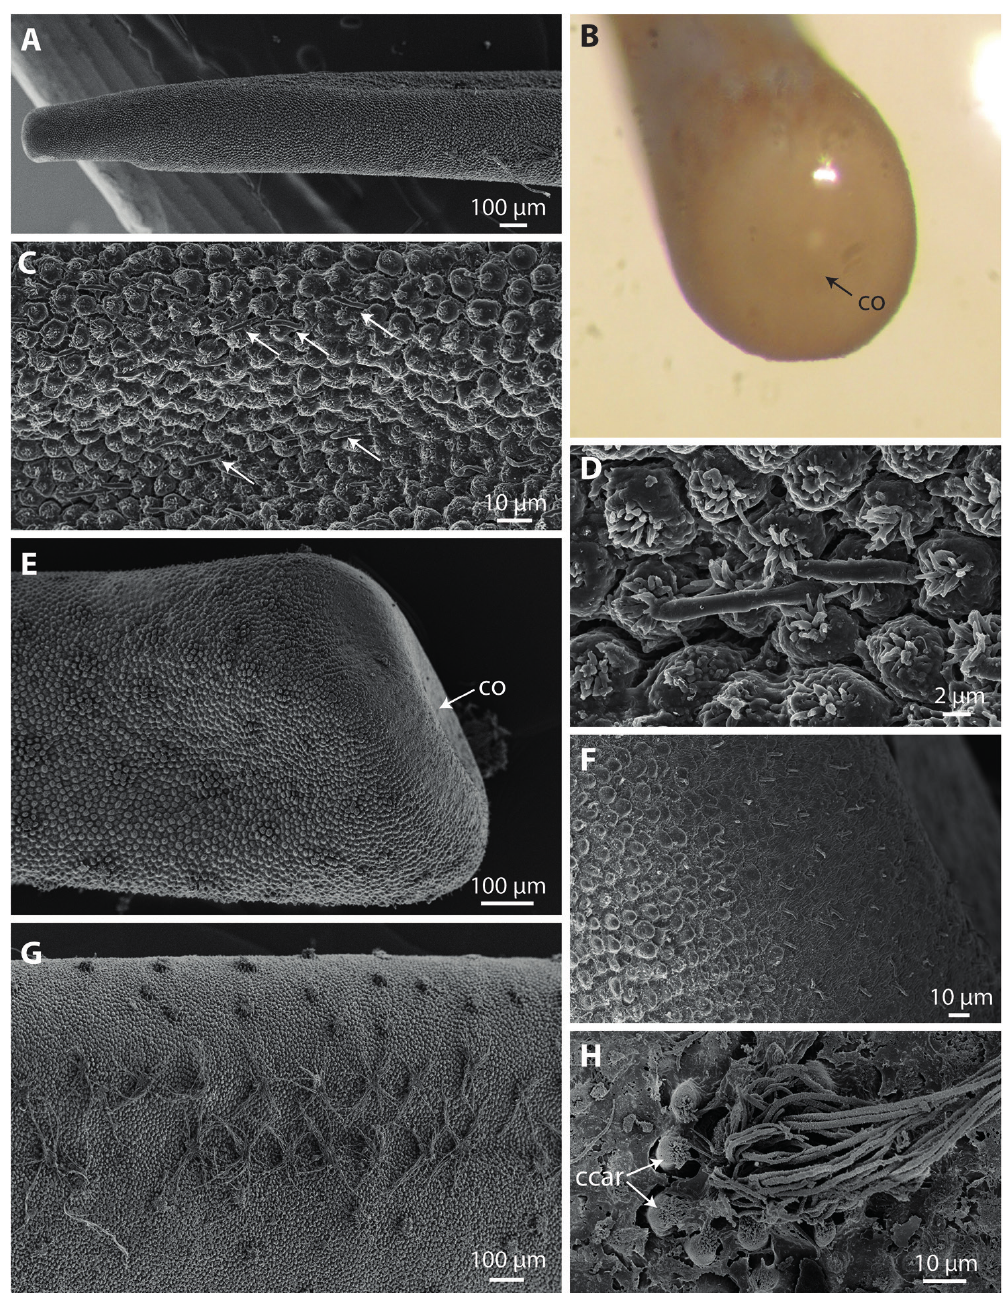
Figure 4. Chordodes colchis , female. A . Anterior end. B. Posterior end with central cloacal opening (co). C, D . Thin tubercles (ar- rows point at some of them) that appear to originate between areoles in the anterior end of the body. E . Lateral view on the posterior end with position of the cloacal opening (co). F. Some bristles behind the region with areoles in the posterior end. G. Clusters of crowned areoles with long filaments along the ventral midline. H . Magnification of a cluster ofcrowned areoles with long filaments and circumcluster areoles (ccar). A, C–H with SEM, B taken with Nicon Coolpix P